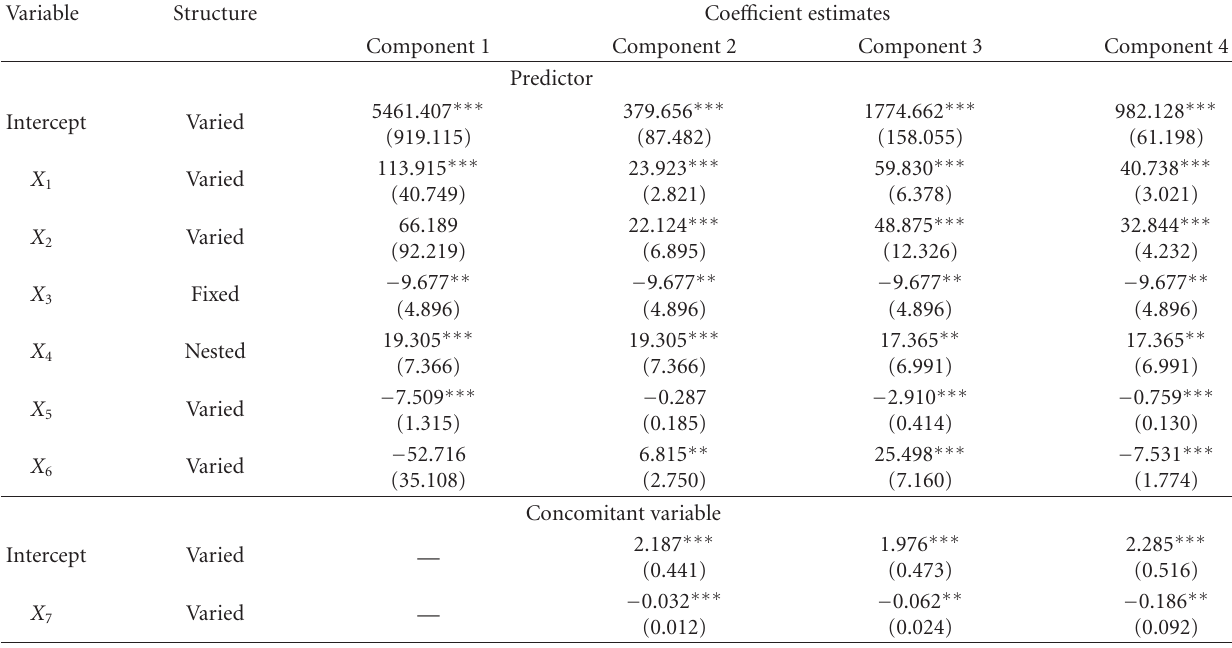
Table 4: Estimation results and variable structure for the finite mixture model a